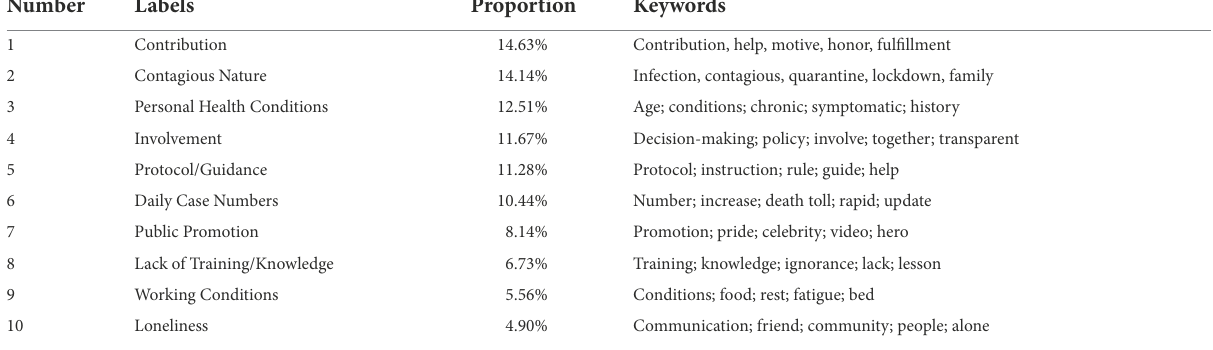
TABLE 1 Topics of volunteer-related Weibo posts generated by